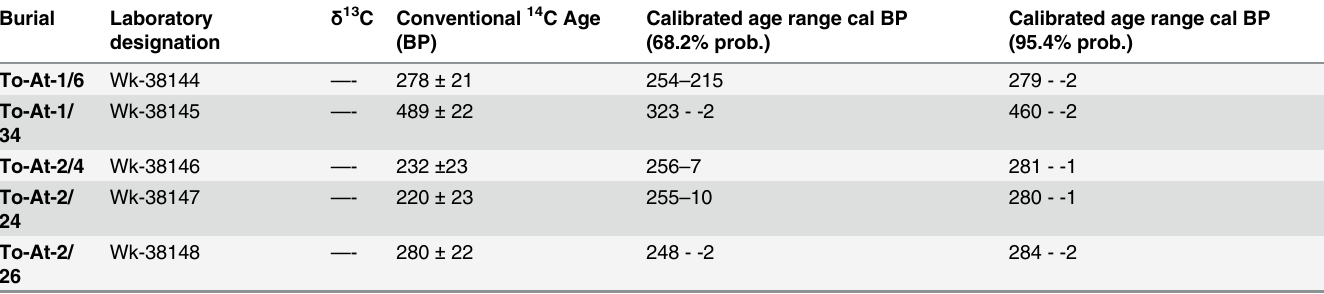
Table 1. Radiocarbon dating results for `Atele burial